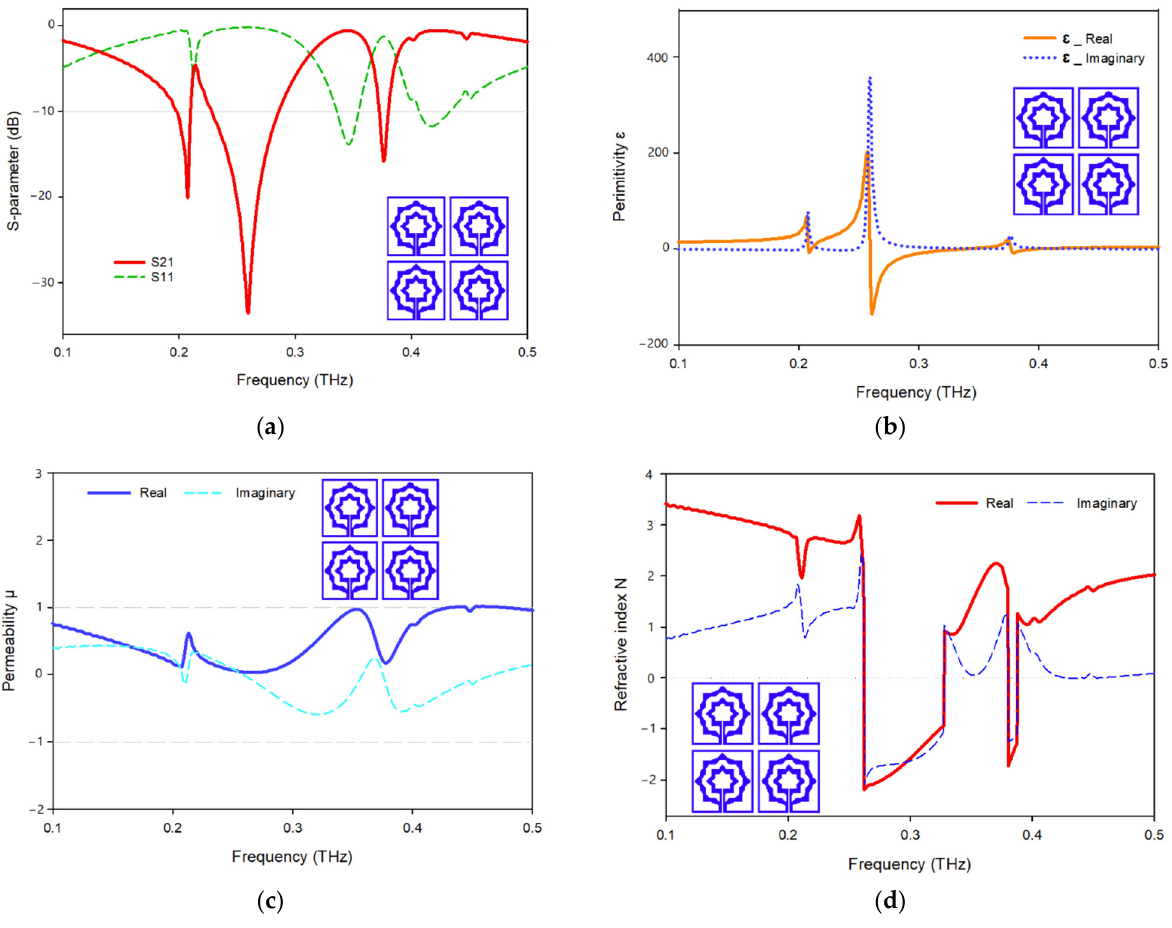
Figure 15. Effective parameters of the 2 × 2 array structure: ( a ) scattering parameters; ( b ) permittivity; ( c ) permeability; ( d ) refractive index.